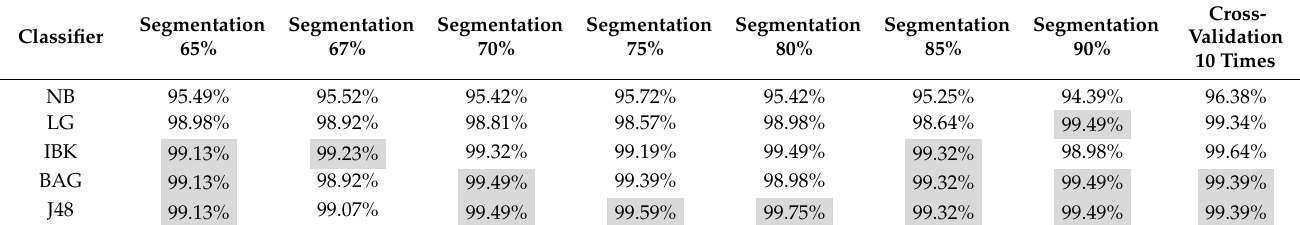
Table 10. The classifier accuracy of feature selection for 1473 normal and 491 bankrupt companies